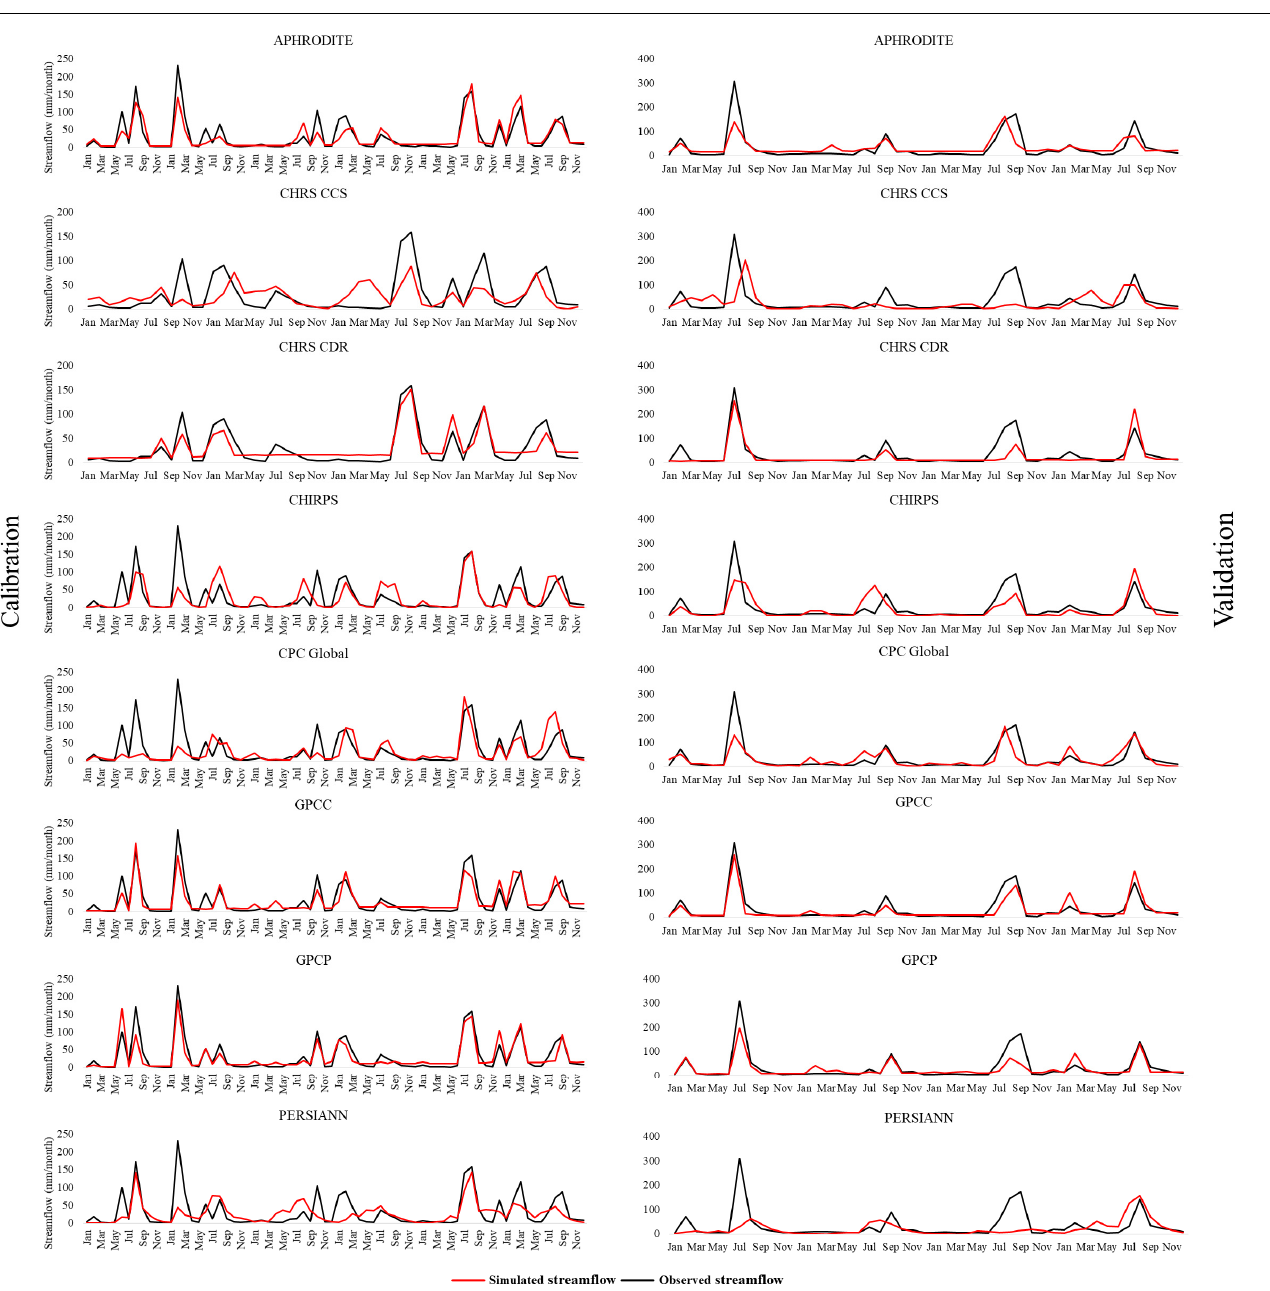
Figure 6. Monthly streamflow during calibration and validations periods simulated by the HBV-light forced with the precipitation input from eight PPs in the Chirah sub-catchment.